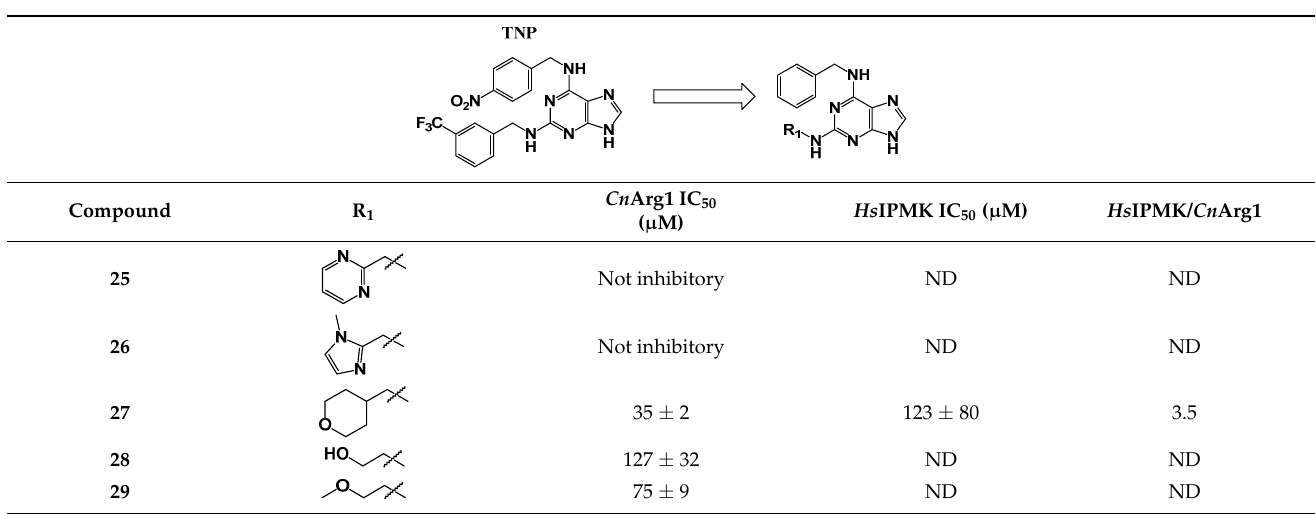
Table 3. Summary of inhibitory properties resulting from chemical exploration at the N 2 position of the TNP purine core following removal of the NO 2 group at the N 6 position (21 analogues). Only Table 3. Cont.